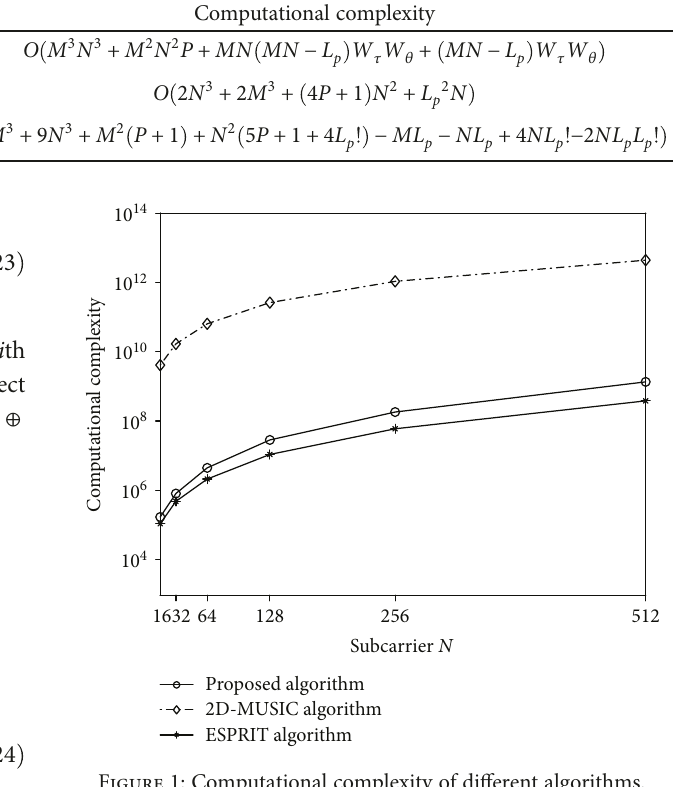
Figure 1: Computational complexity of di ff erent